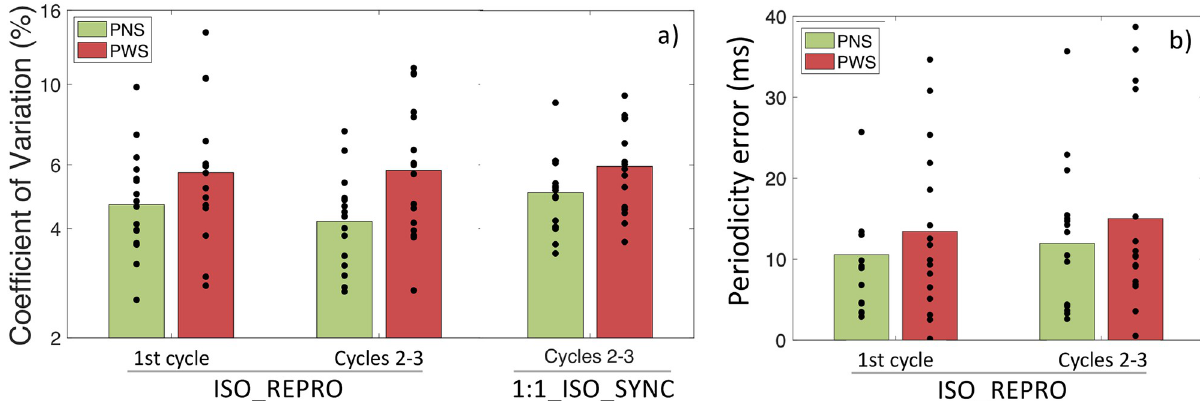
Fig 3. (a) Coefficient of Variation (CV), inversely related to the degree of isochrony of the reproduced pattern, measured over the very first taps or the stabilized phase of ISO_REPRO, compared to the stabilized phase of the synhcronization task 1:1_ISO_SYNC. People who stutter (PWS, N = 16) are compared with typical adults without speech disorder (PNS, N = 16). (b) Average Periodicity Error (PE) when reproducing the specific 500ms period of the previously heard isochronous pattern of the condition ISO_REPRO, over the very first taps (first 8-beat cycle) or the more stabilized phase (second and third 8-beat cycles) of the